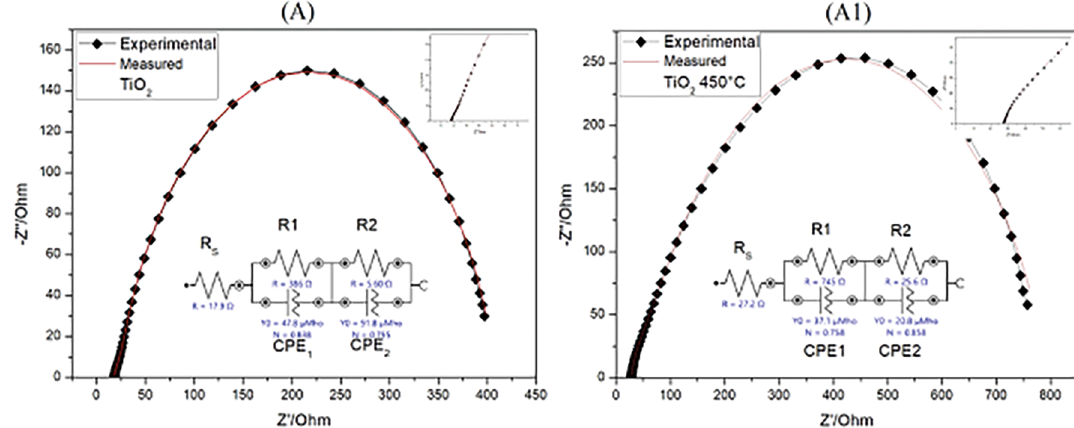
and (A1) TiO -450 °C. 2 2